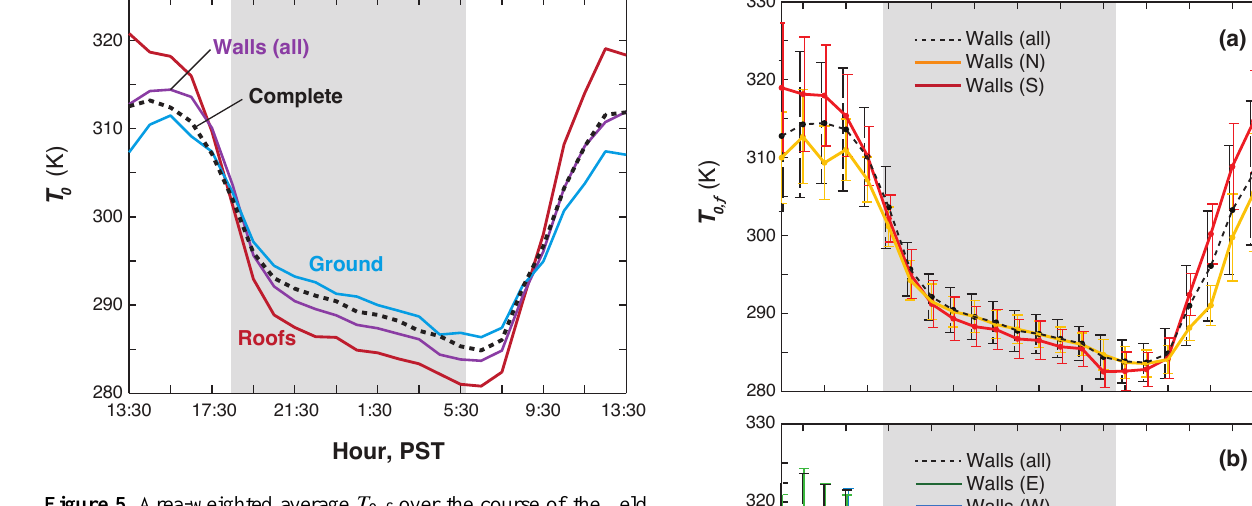
Figure 5. Area-weighted average T 0 , f over the course of the field observations along with complete surface temperature T 0 , C . The shaded area is nighttime.